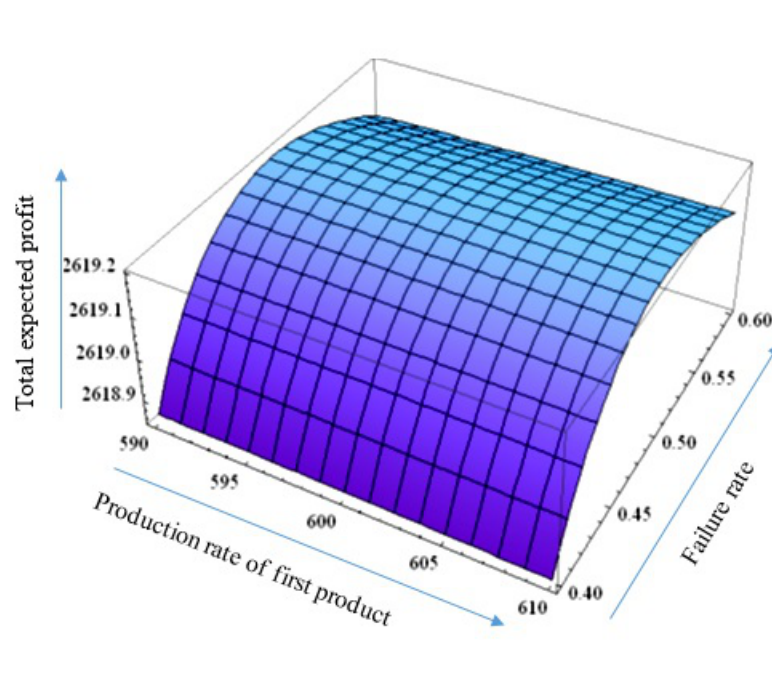
Figure 6. The total expected profit versus the production lot size q 1 and failure rate α .